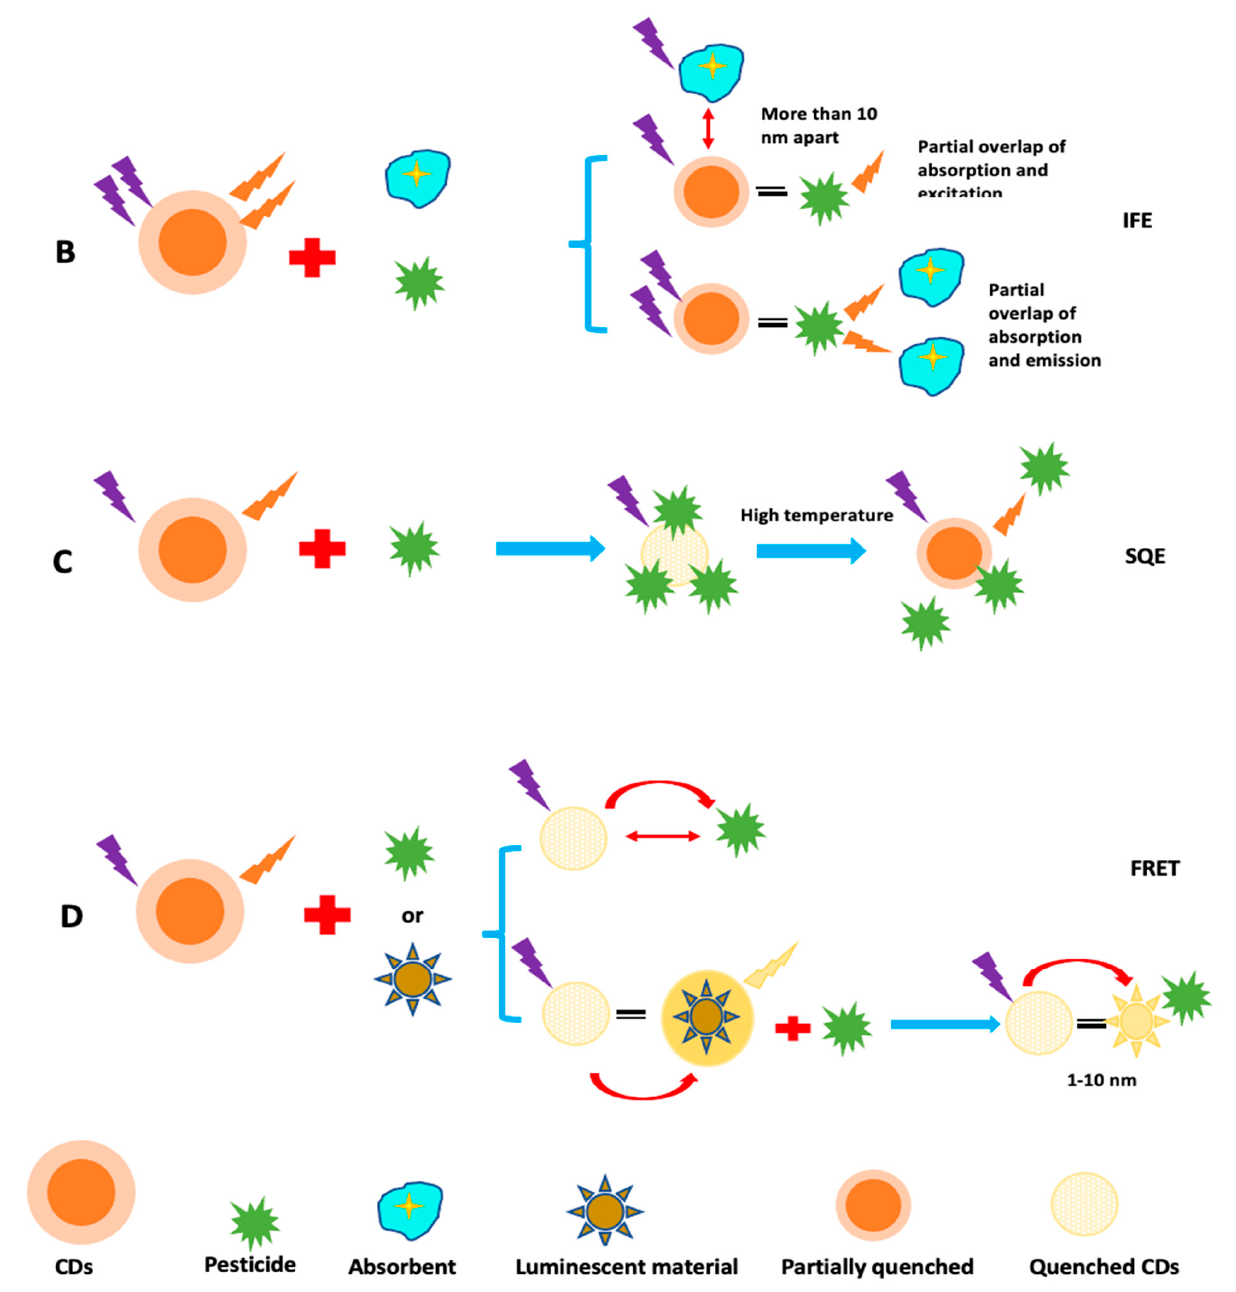
Figure 11. Sensing mechanism of fluorescent CDs: ( A ) PET; ( B ) IFE; ( C ) SQE; and ( D ) FRET.